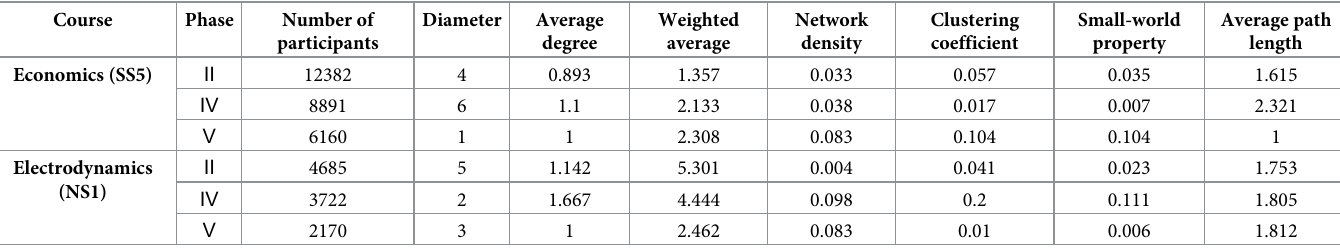
Table 7. Comparison of various indicators for Economics and